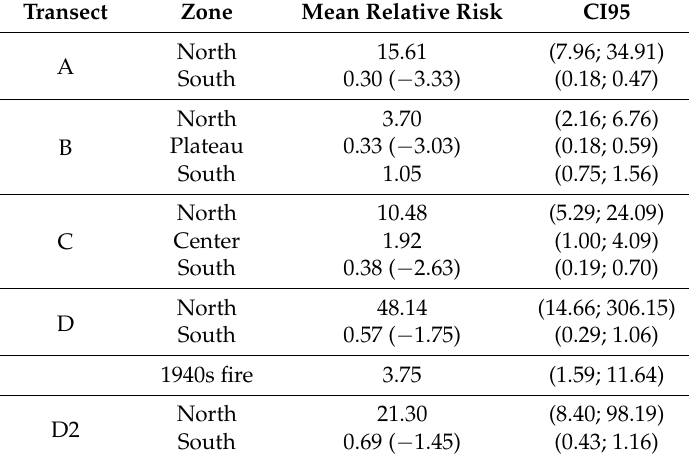
Table A1. Mean relative fire risk of transect zones compared to mean risk of the transect with 95% bootstrap confidence intervals (CI95) (e.g., zone north of transect A has a risk 15.61 times higher than the mean risk of the transect, while zone south of the same transect has a risk 3.33 times lower or equals to 0.30 times the mean risk of the transect). Relative fire risk values take into account the down-weighting of recently burned